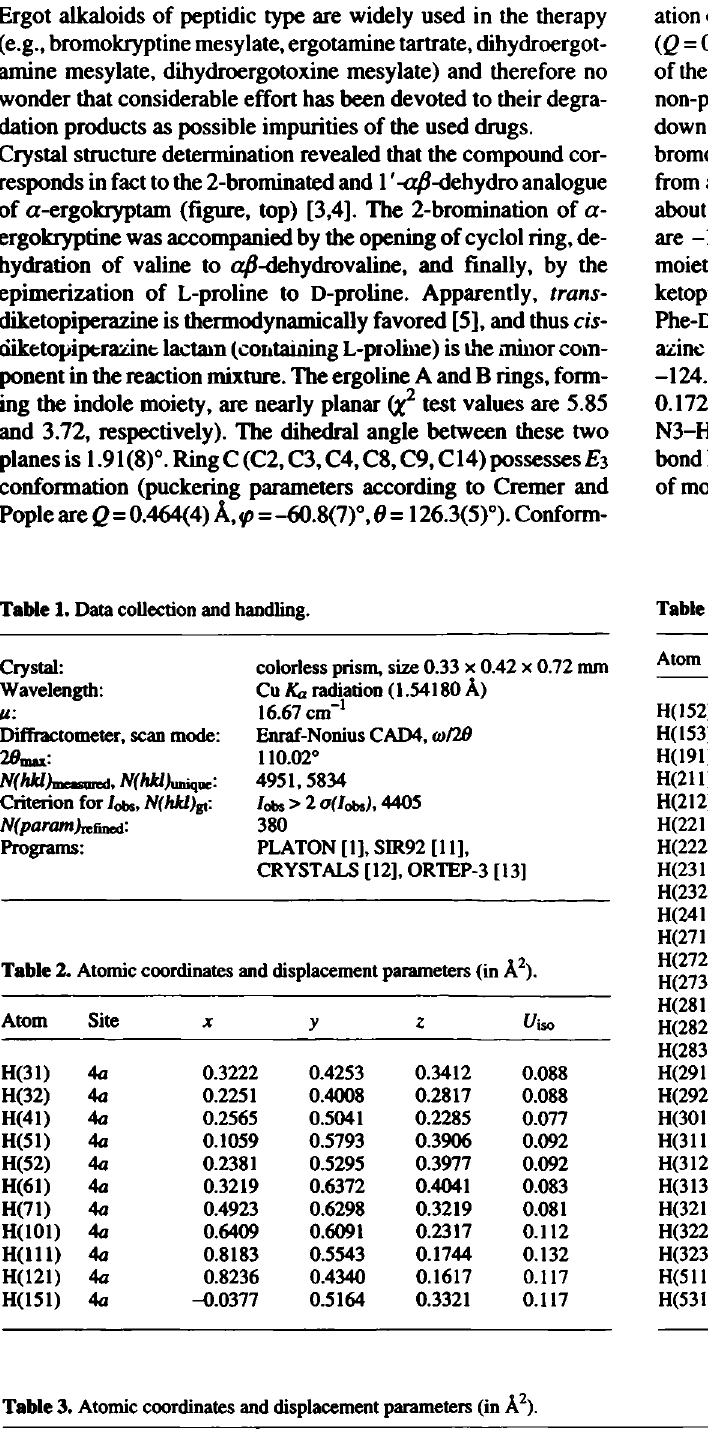
Table 3. Atomic coordinates and displacement parameters (in A 2